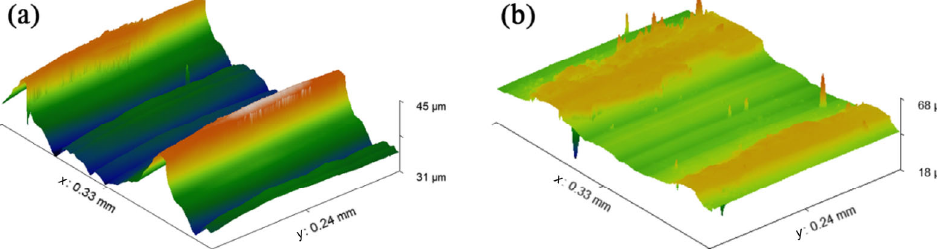
Fig. 8 LSCM images at 50× magnification of the stem trunnion: (a) before ( R Z = 12.14±0.29 μ m) and (b) after ( R Z = 14.96±1.48 μ m) the